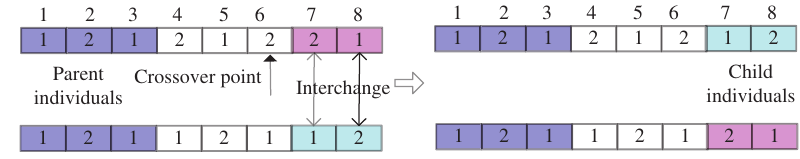
Figure 4. Illustration of One-Point Crossover. See online version for